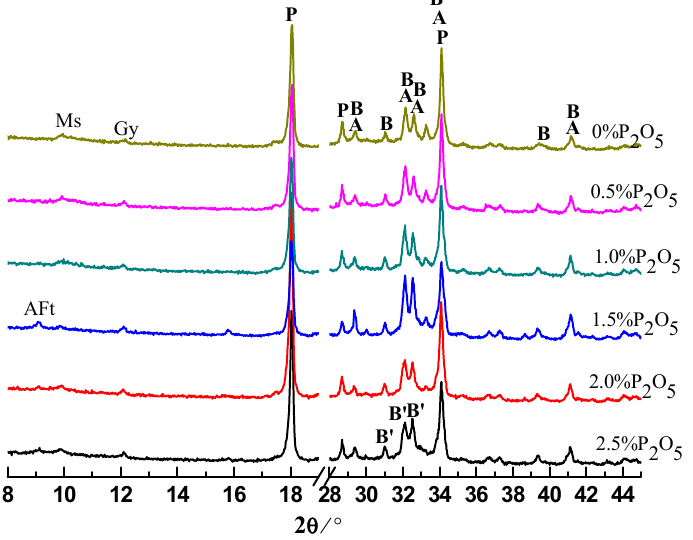
Figure 6. XRD patterns of cement pastes hydrated for 28 days. A: C 3 S; B: β -C 2 S; P: CH; Ms: AFm; B ′ : α′ -C 2 S-0.05C 3 P.